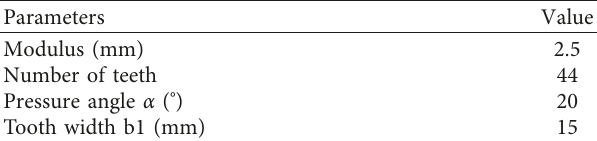
Table 1: Basic parameters of the drum teeth joint